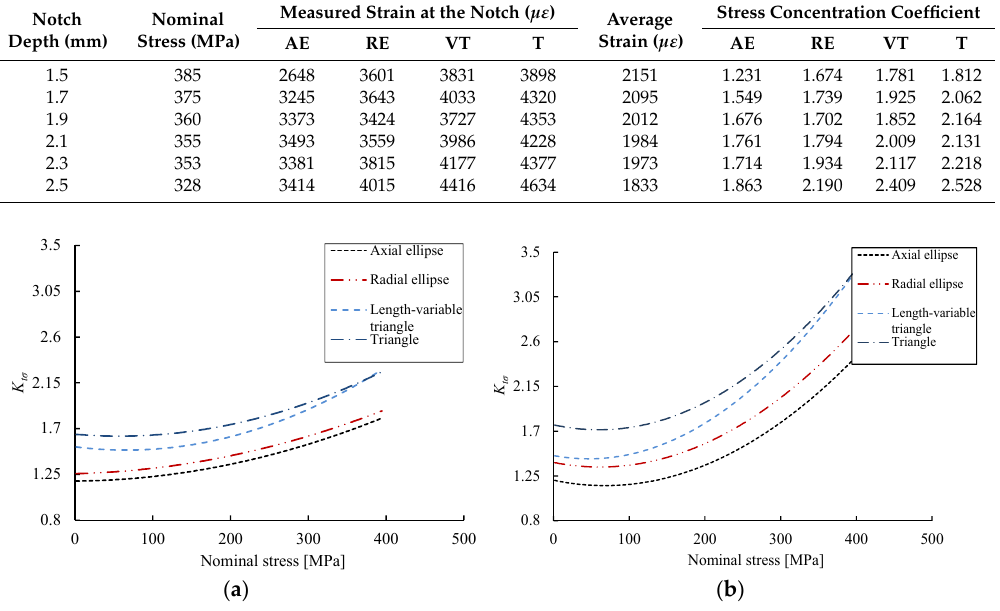
Table 2. Stress concentration coefficients for different notch shapes and notch depths.